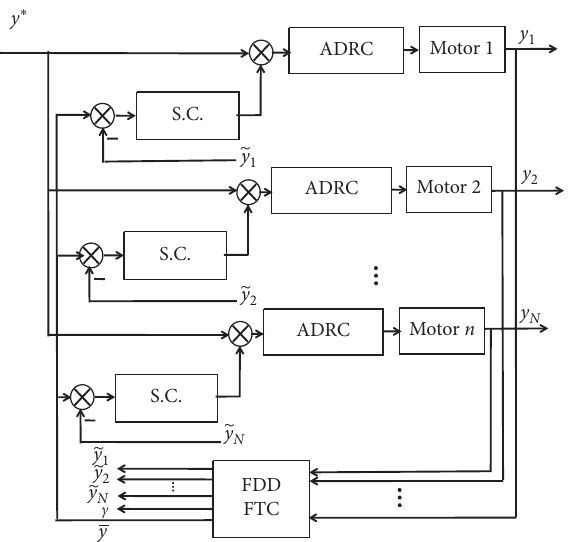
Figure 2: Improved structure with FDD and FTC functions.